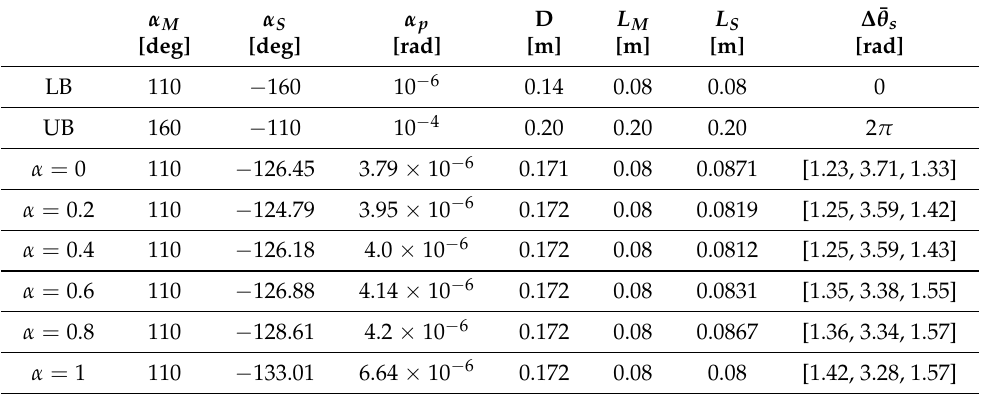
Table A2. The resulting (optimized) parameter values of co-design case 2 given variable weight α .